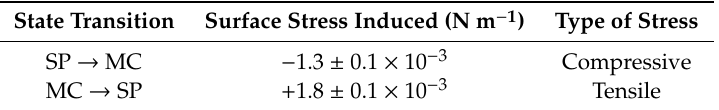
Table 1. The surface stress induced as a result of SP / MC